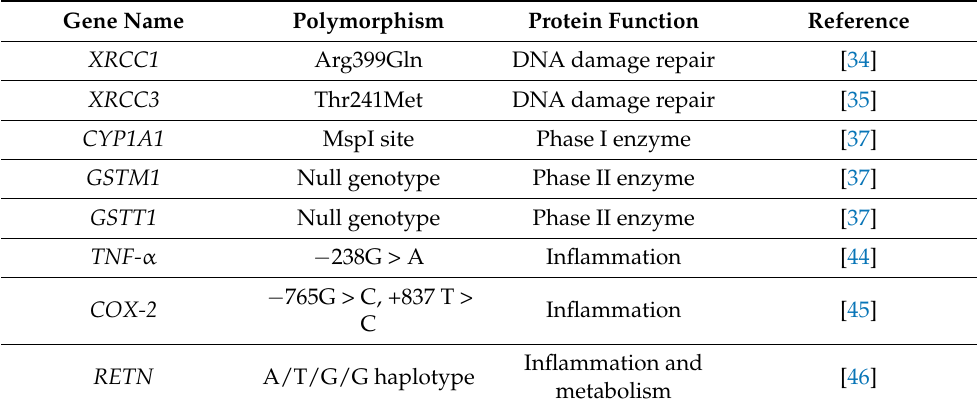
Table 2. Examples of gene polymorphisms associated with oral cancer